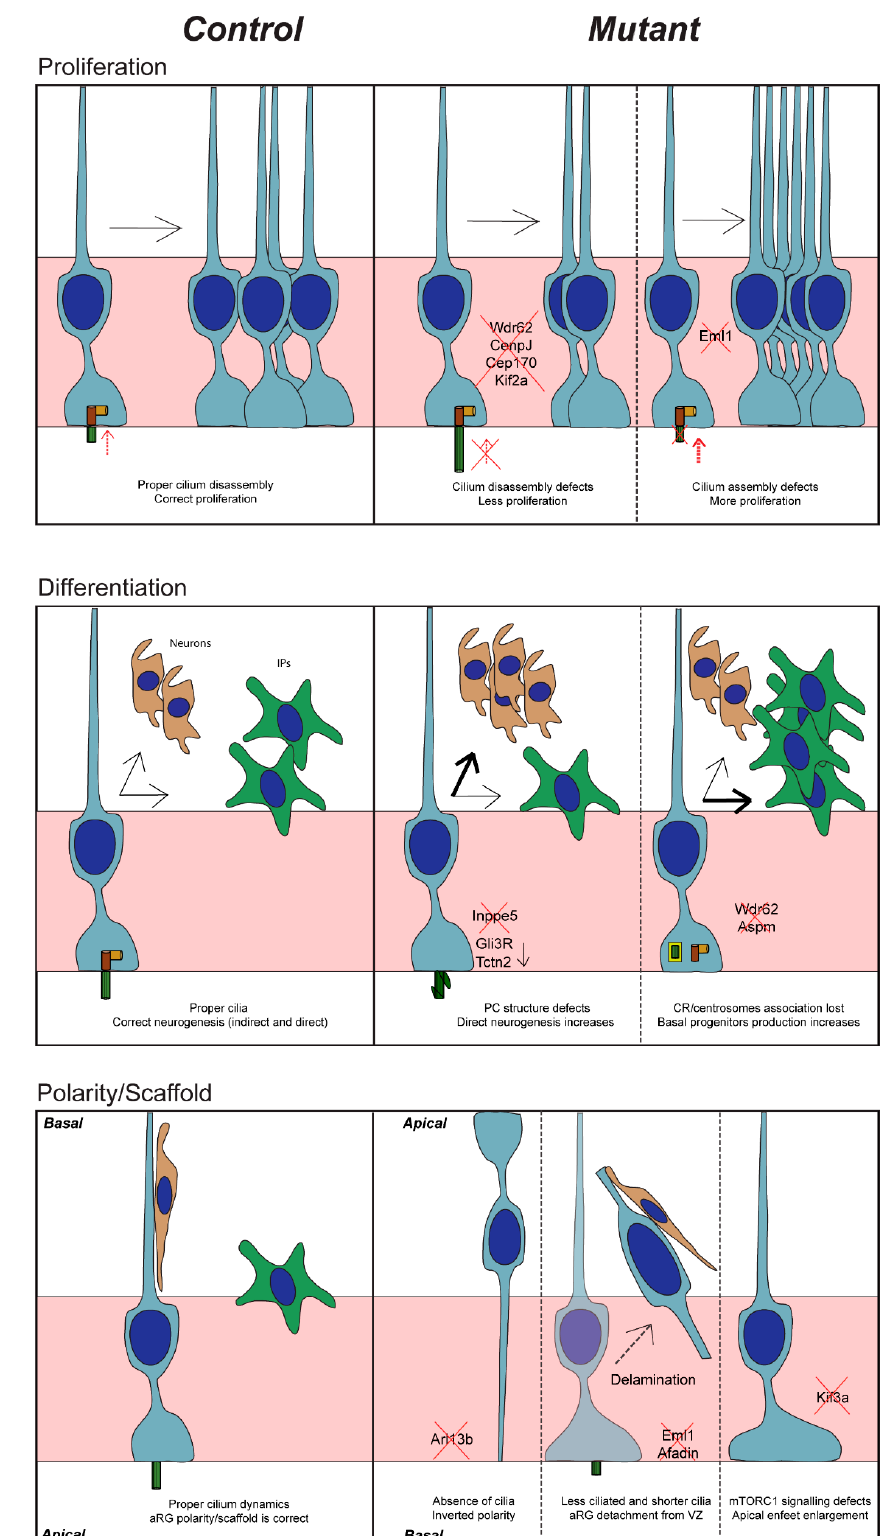
Figure 4. PC impacts on aRG behaviour. Graphical schema of PC defects and their impact on aRG. On the left, the control situation for proliferation, differentiation, scaffold/polarity are represented and in the right panel, the mutant condition with a non-exhaustive list of involved ciliary factors. The red cross refers to an absence of proteins or an alteration of a